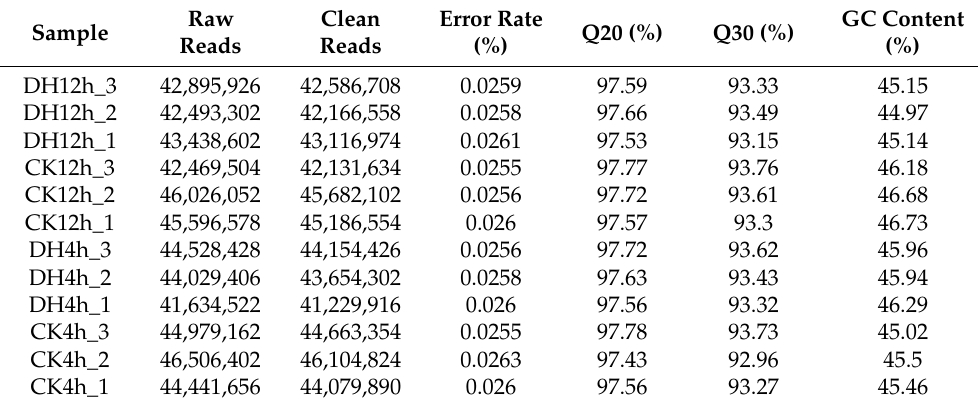
Table 1. Summary of the transcriptome sequencing data from the control and DH-treated